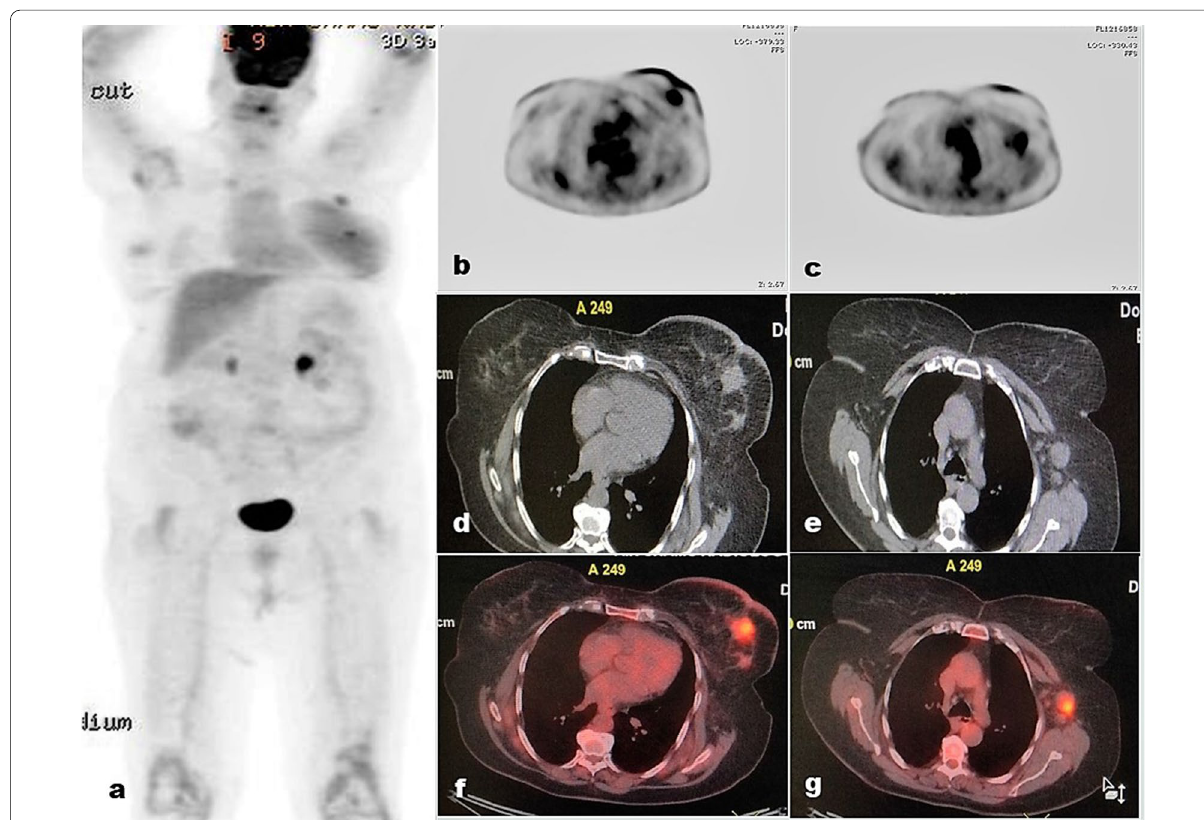
Fig. 2 60 years old patient with recently diagnosed left sided HER2 positive breast carcinoma. TLR projection. b and c Trans axial PET images corresponding axial CT cut in d and e shows left breast retro-areolar isodense soft tissue mass lesion associated with skin thickening. It measures about 5 2 1.7 cm. f fused PET/CT axial cut shows left breast retro-areolar FDG avid lesion displaying SUVmax ~ 4.7. g fused PET/CT axial cut show FDG avid × axillary lymph node displaying SUVmax ~ 4.8